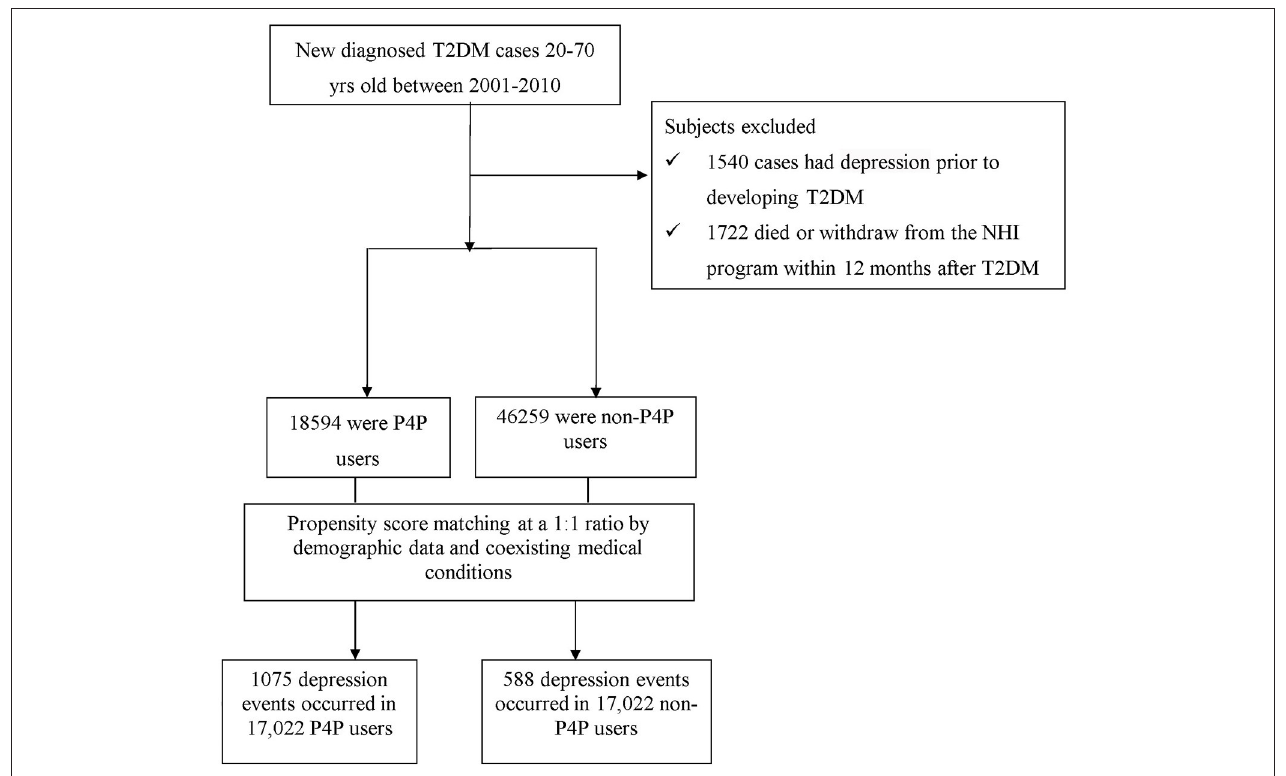
FIGURE 1 | Flow chart of selection and follow up of study